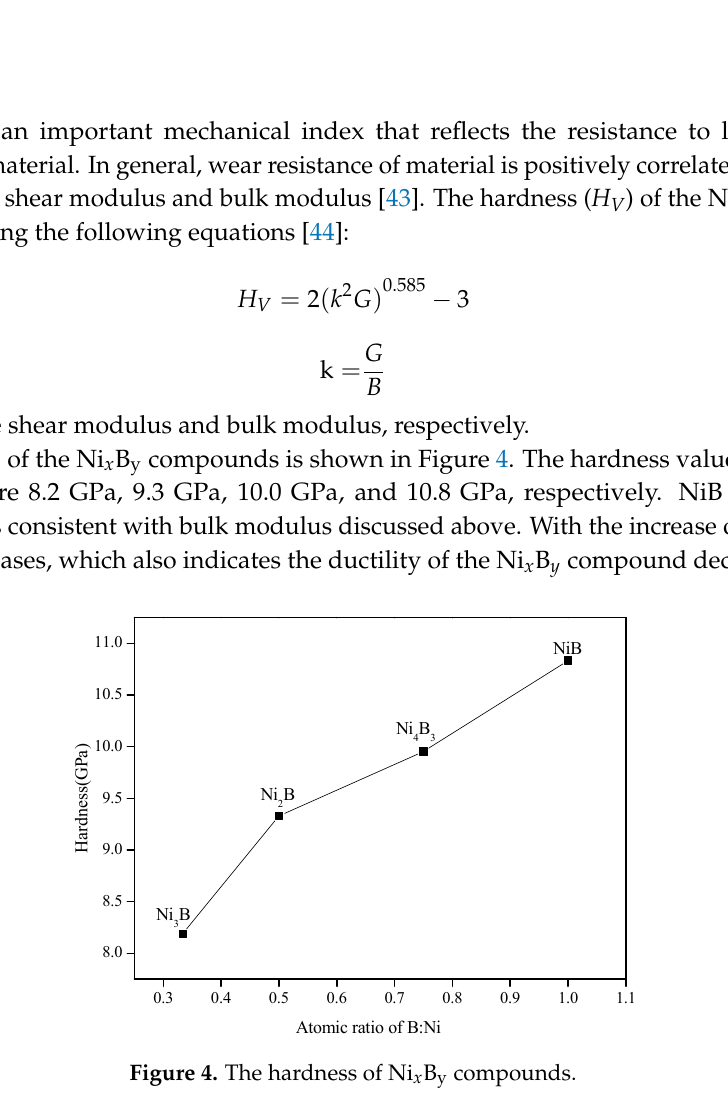
Figure 3. Planar projections of the Young’s modulus of Ni x B y compounds ( a ) (X-Y) planar; ( b ) (X-Z) planar; ( c ) (Y-Z) planar.